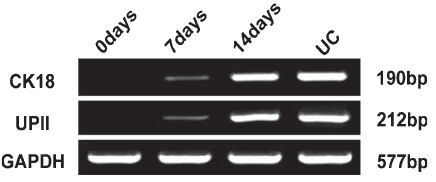
Fig. 2. hUCMSCs were analyzed by RT-PCR after urothelial dif- ferentiation. hUCMSCs were cultured with UC-CM supplemented 20ng/ml exogenous EGF. After differentiation, hUCMSCs were analyzed by RT-PCR with uroplakin II (UP II) and cytokeratin 18 (CK18). UCs were used as positive control. GAPDH primers were used as an internal